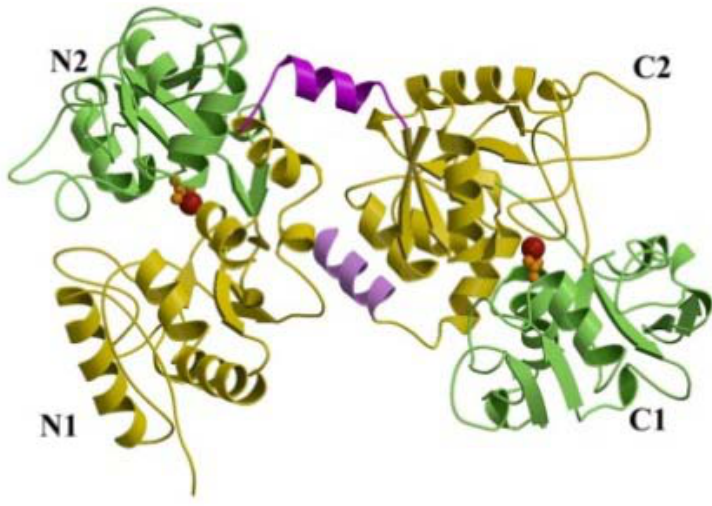
Figure 1. Structure of lactoferrin. From Baker and Baker